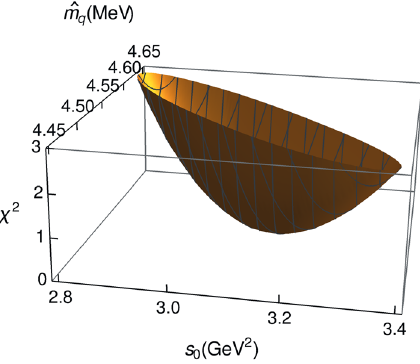
Fig. 6 χ 2 as a function of s 0 and ˆ m q , where the central condensate values, the central phenomenological spectrum and κ = 3 . 0 are taken.